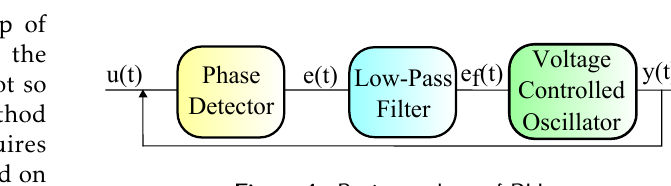
Figure 1. Basic topology of